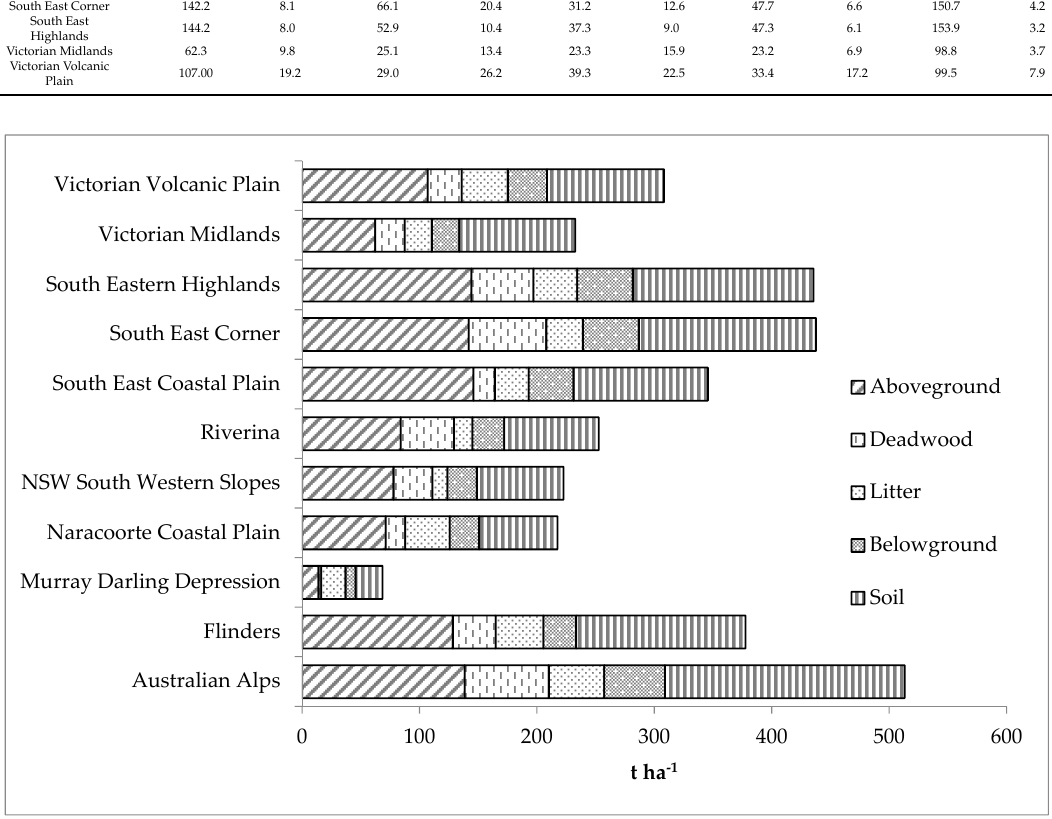
Figure 2. Carbon stock per hectare in the Victorian bioregion categories across the five carbon pools.